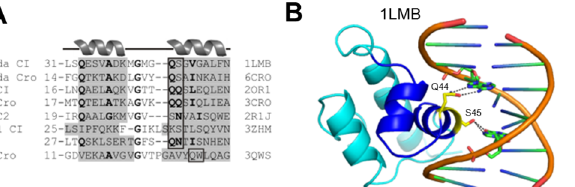
Fig 3. DNA binding domain of bacteriophage repressors. (A) Sequence alignment of the HTH motifs of bacteriophage repressors and Stl. The number before each segment is the amino acid sequence number of the first residue in the sequence. Helices are with gray background, similar residues are in bold, box highlights residues interacting with DNA nucleobases. PDB ID of the proteins is indicated on the right side of the sequences. (B) Experimentally determined structure of the DNA-bound CI bacteriophage repressor DNA cartoons orange, protein cartoon: dark blue for HTHs, otherwise cyan. DNA bases and DNA interacting amino acid residues are stick representation with atomic coloring (protein carbon yellow, DNA carbon green, oxygen red, nitrogen blue, phosphorus orange.) The PDB ID of the structure is indicated. Stereo representation of all experimentally determined protein-DNA complex structures represented in the sequence alignment in this figure are available in S3 – S9 Figs.